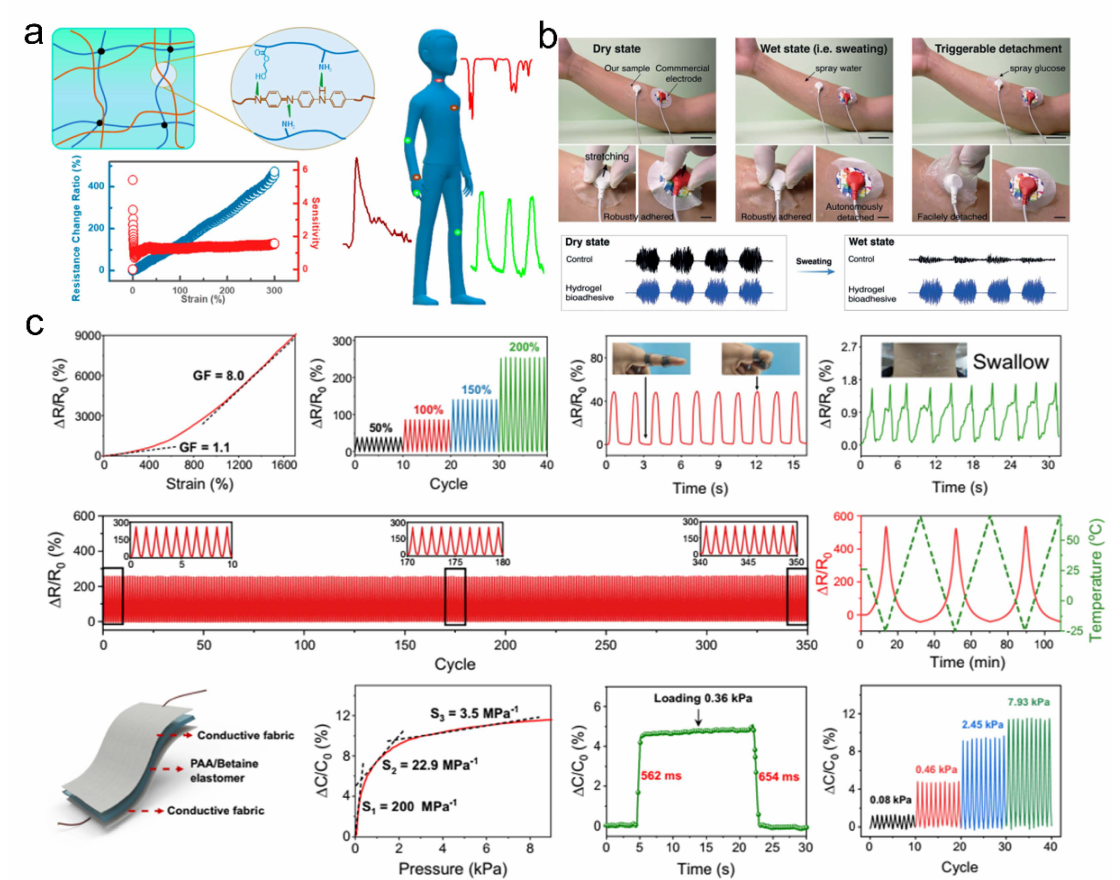
Figure 9. ( a ) The strain sensor for reliable detection of human activities by a tough and electrically con- ductive hydrogel, which comprised hydrogen-bonding-crosslinked PANI and P-(AAm-co-HEMA). Reproduced with permission [127]. Copyright 2018, American Chemical Society. ( b ) The physiolog- ical signal EMG was measured through a hydrogel adhesive with tough and reversible adhesion. Reproduced with permission [128]. Copyright 2021, John Wiley and Sons. ( c ) Multifunctional electronic devices for the detection of strain, pressure, and temperature signals on the human